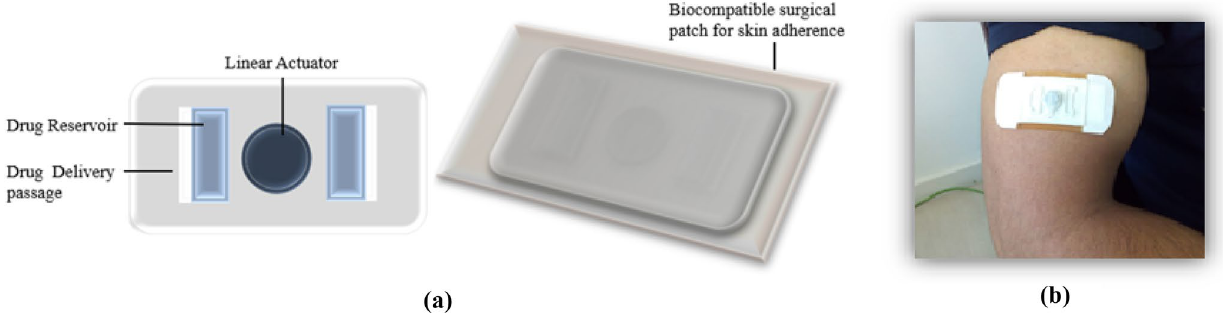
Fig. 1 a Conceptual view of device loaded with drugs b Device